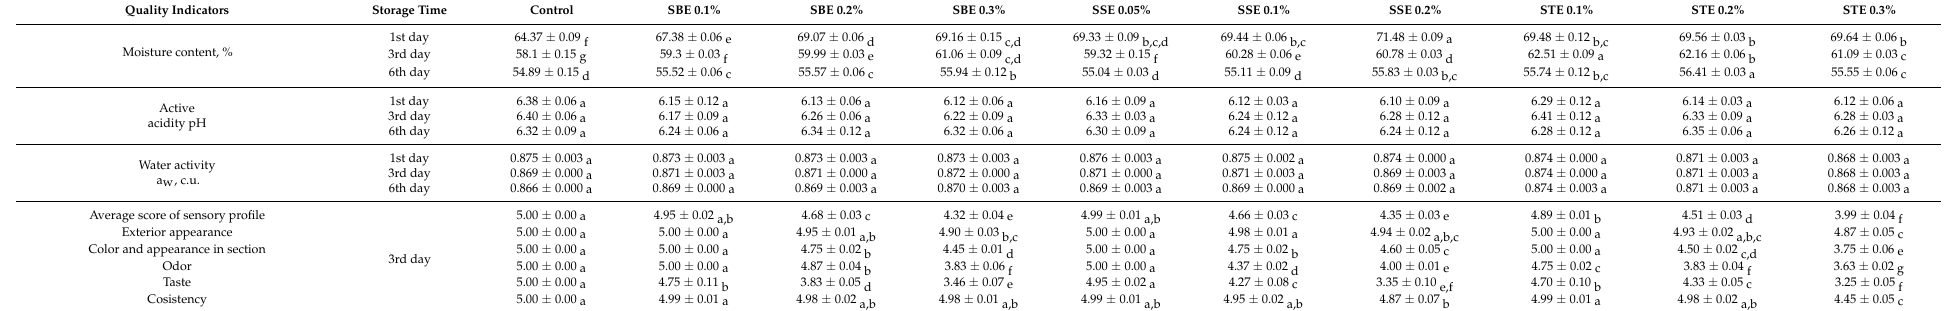
Table 2. Physicochemical quality indicators and sensory profile of sausages with added lyophilized extracts of basil, summer savory and tarragon compared to the control (the results are presented as means ± standard